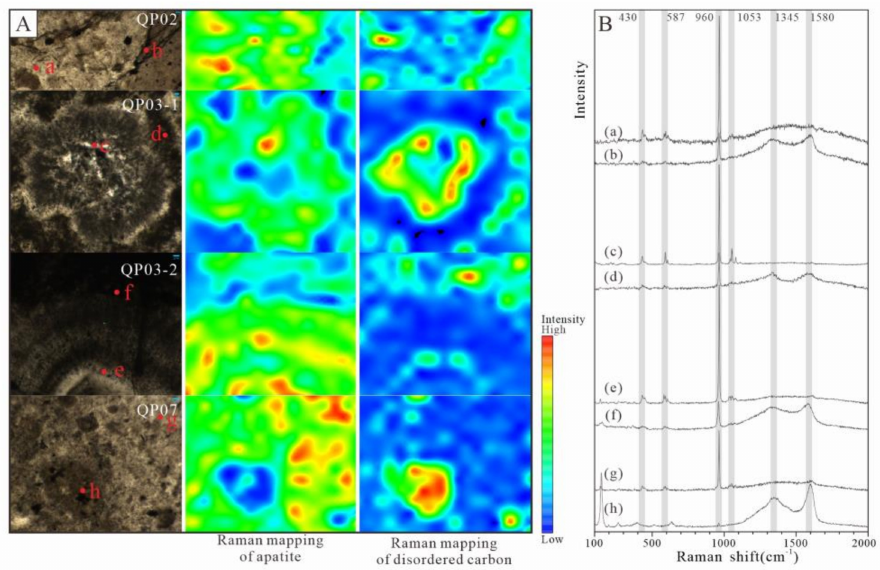
Figure 3. ( A ) The representative points of Raman analysis of phosphate rock. ( B ) Distribution characteristics of apatite and organic matter. Notes: a,c,e,g are typical points of apatite, b,d,f,h are typical points of organic-matter-bearing